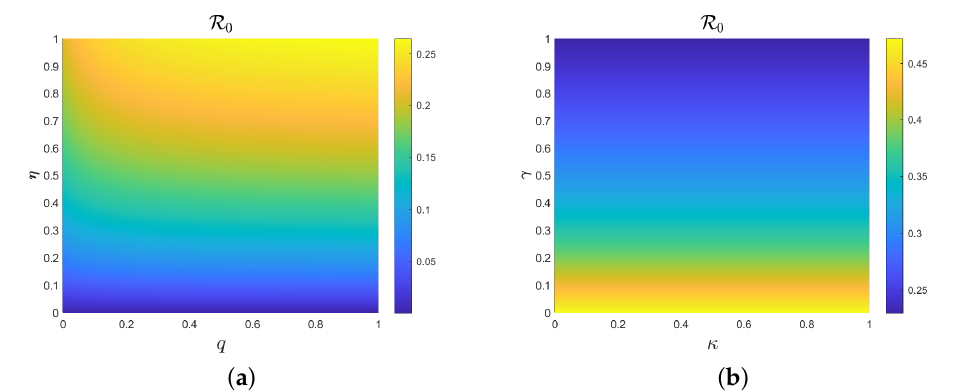
Figure 1. Sensitivity analysis of reproduction number according to the model parameters for ( a ) η and q , ( b ) γ and κ